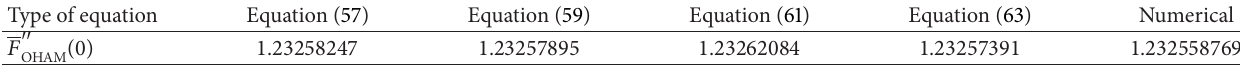
Table 17: Comparison between OHAM results for velocity 𝐹